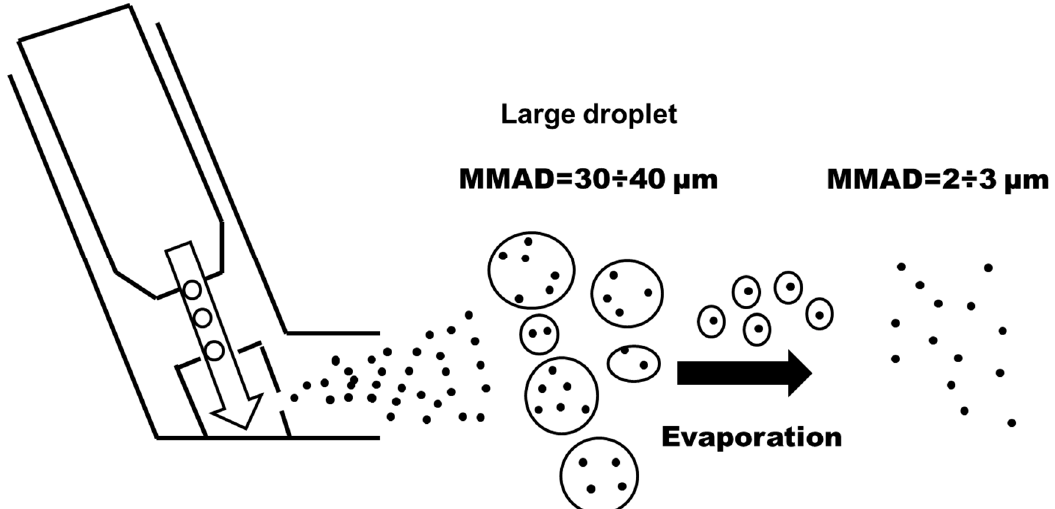
Figure 16. Diagram of a typical pressurized metered dose inhaler showing the mechanism of particle formation (MMAD = mass median aerodynamic diameter). Adapted from Figure 1 in [78].